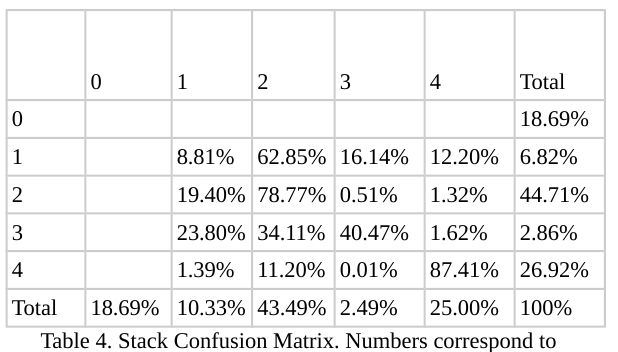
Table 4. Stack Confusion Matrix. Numbers correspond to classification identification